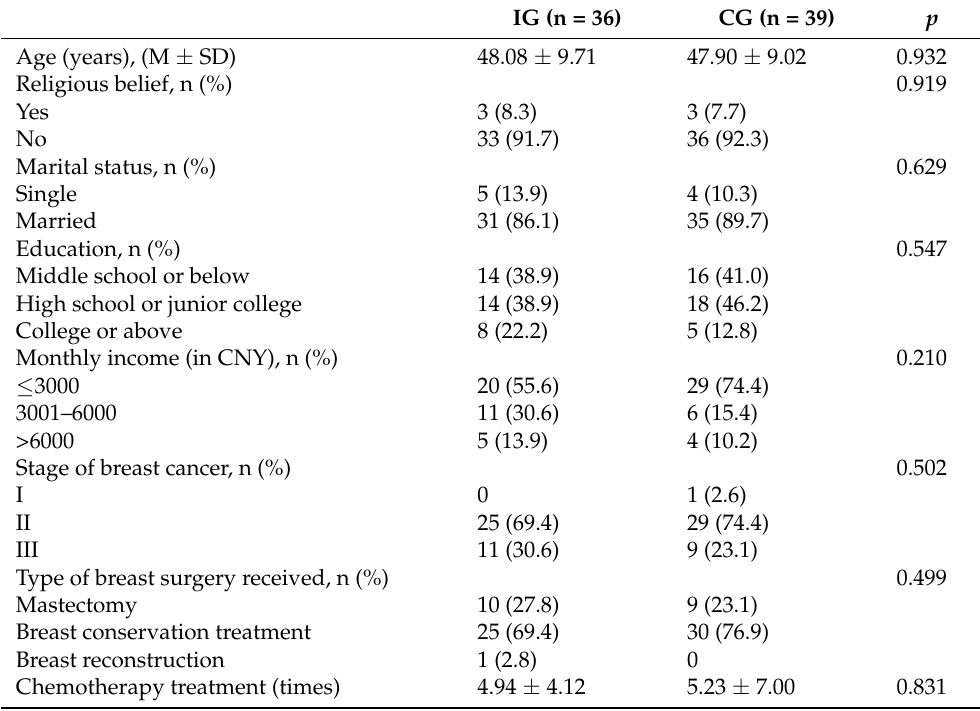
Figure 1. CONSORT Diagram. Table 2. Comparison of sociodemographic characteristics between IG and CG.